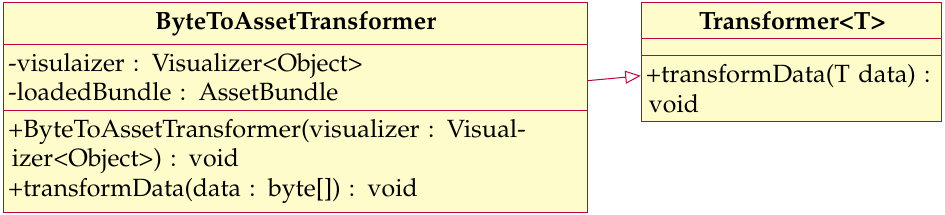
Figure 17. Class diagram of the ByteToAssetTransformer with all the functions and fields, and its connection to its parent